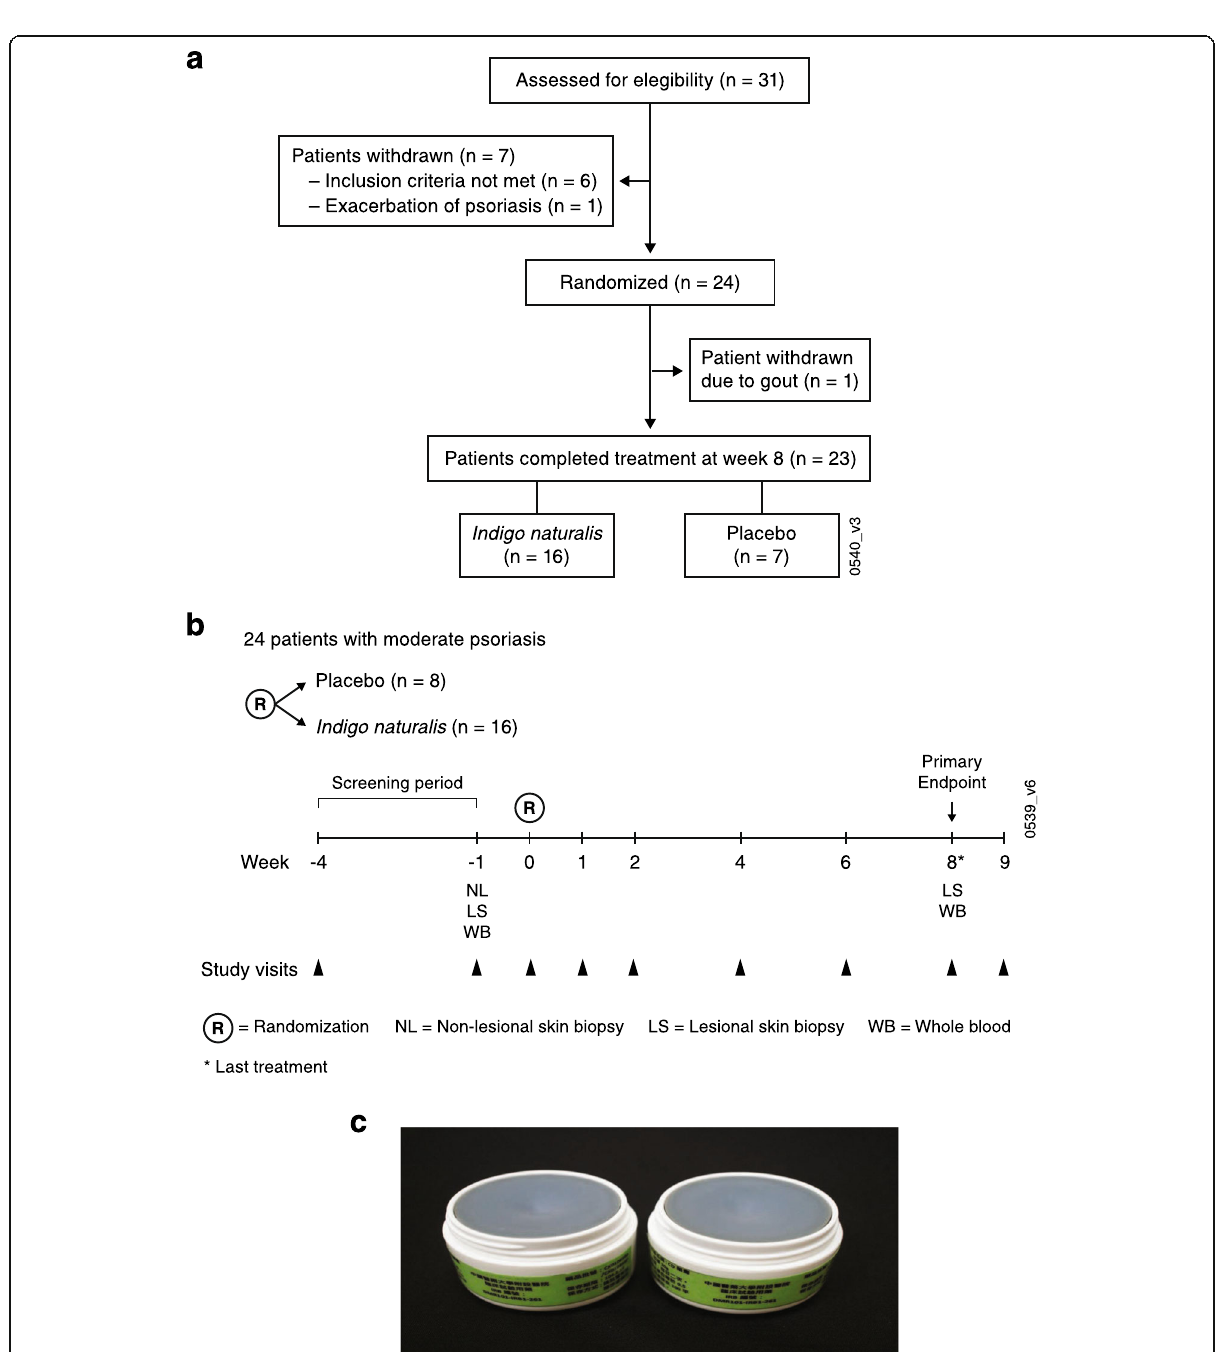
Fig. 1 Study design. ( a ) Patient disposition; ( b ) study design; ( c ) study agent and placebo. The Indigo naturalis ointment used was a mixture